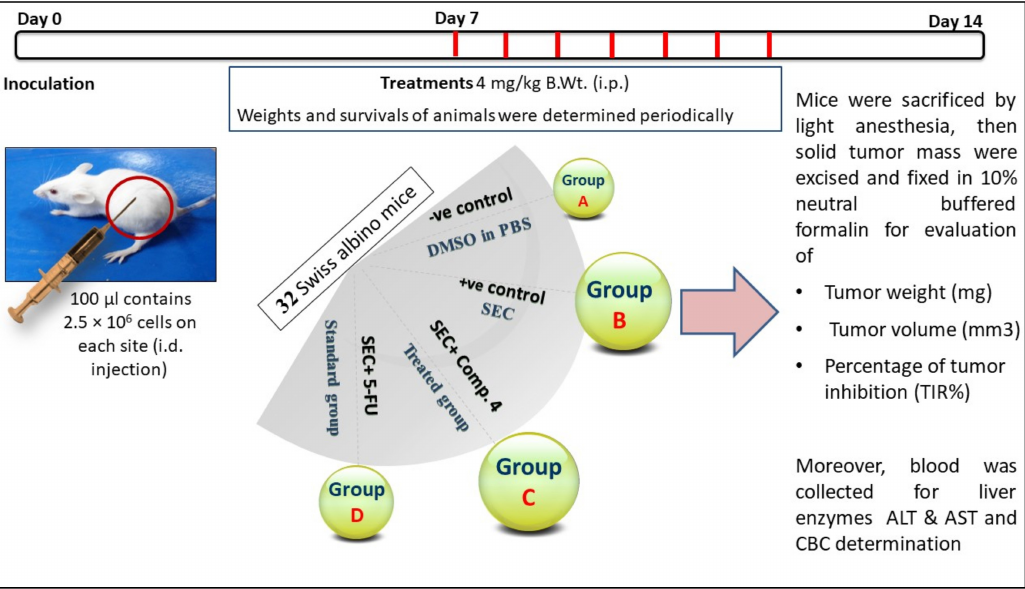
Figure 7. Summarized methodology of Solid Ehrlich Carcinoma (SEC)-bearing mice in